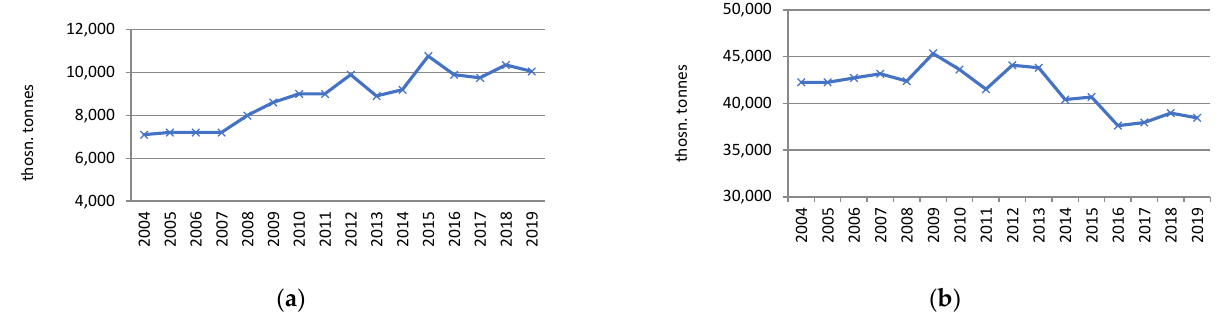
Figure 2. Coal consumption in: ( a ) households; ( b ) power plants and CHP plants [41].